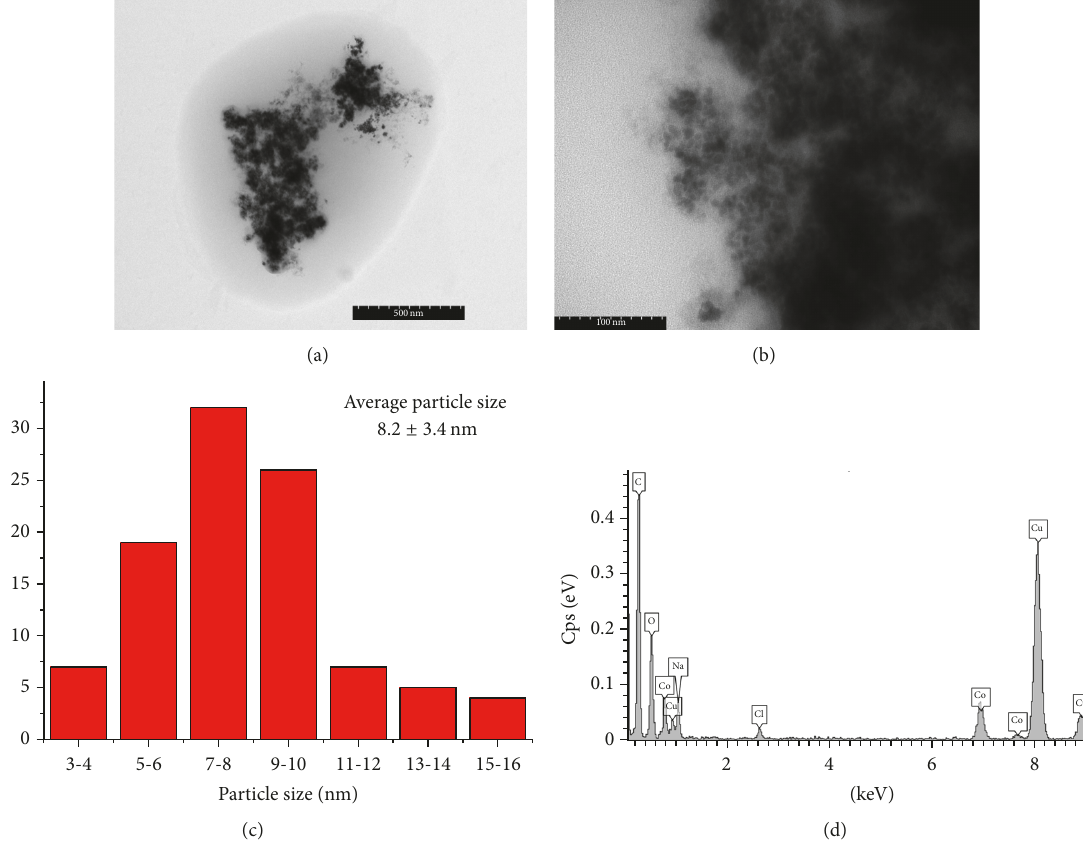
Figure 12: TEM images CoNPs (12: 1) (a, b), corresponding particle-size distribution of CoNPs (c), and EDS spectrum (d) for the area corresponding to (a). The Cu signals come from TEM